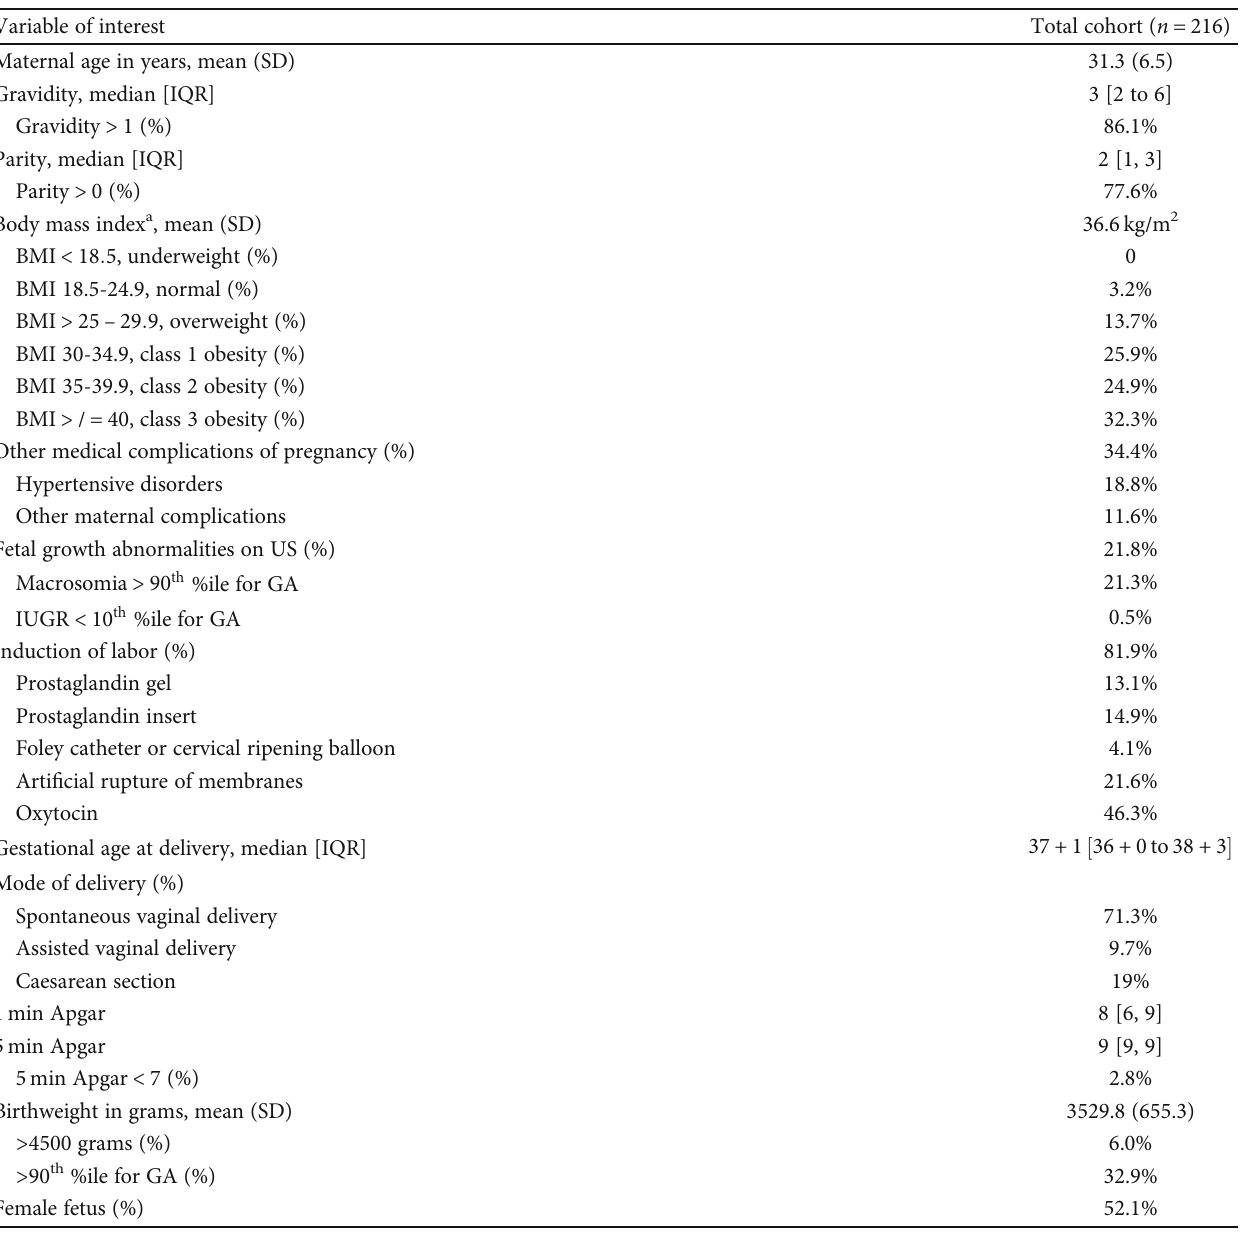
Table 1: Maternal characteristics and peripartum outcomes associated with pregnancies a ff ected by pregestational type 2 diabetes. Variable of